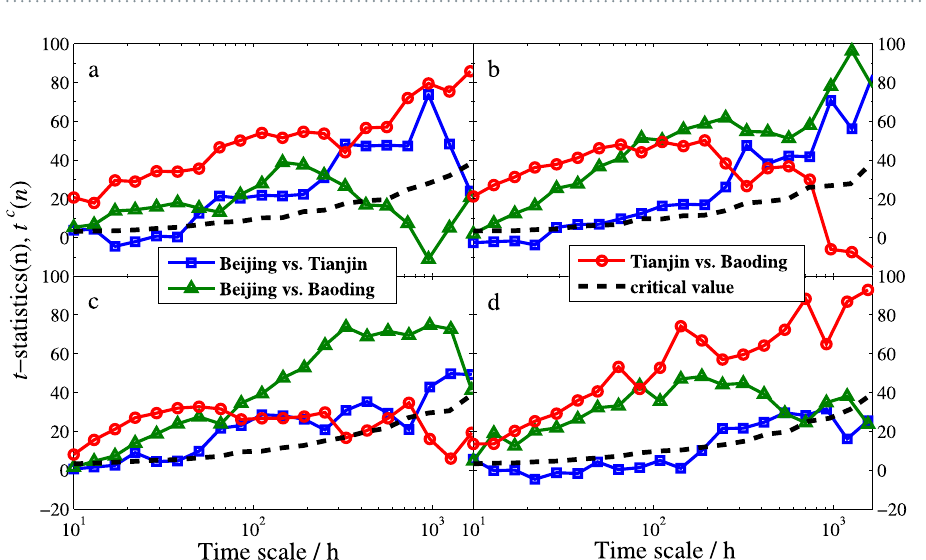
Figure 8. t -statistical test of the estimated DFA-based bivariate regression coefficients. ( a – d ) Are for winter, spring, summer, and fall, respectively. The dashed line represents the t c ( n ) with 0.01 significant levels. Above this line means to decline the null hypothesis β j =